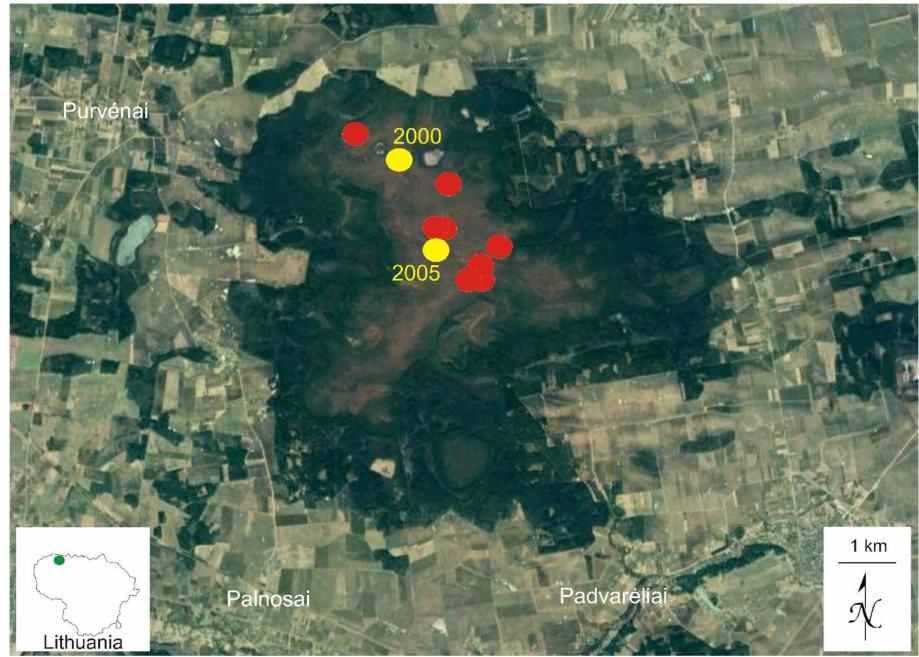
Figure 1. Distribution of Splachnum pensylvanicum in Kamanos mire and in Lithuania (inset). The records made in summer– autumn 2017 are marked with red